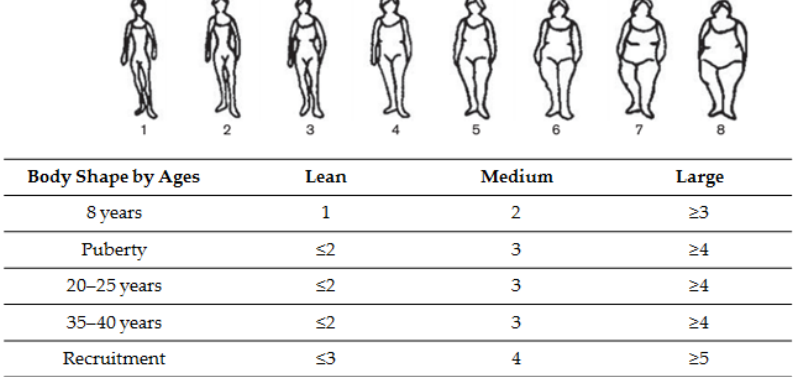
Figure 1. Classification of body shape at different ages, using Sørensen’s pictograms [19].